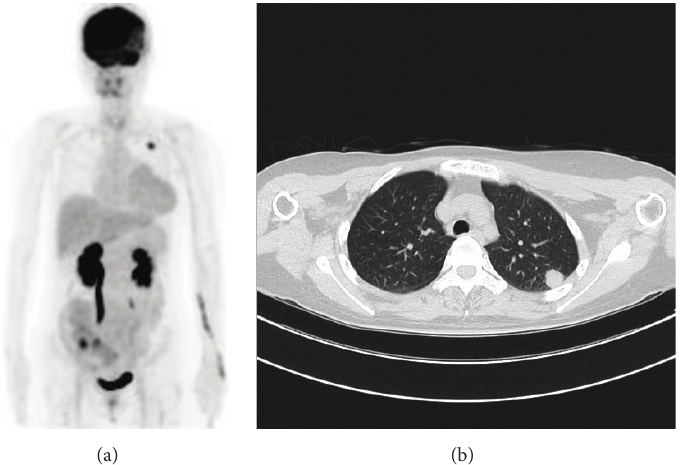
Figure 4: Positron emission tomography-computed tomography indicates the presence of lung metastasis at the left lung